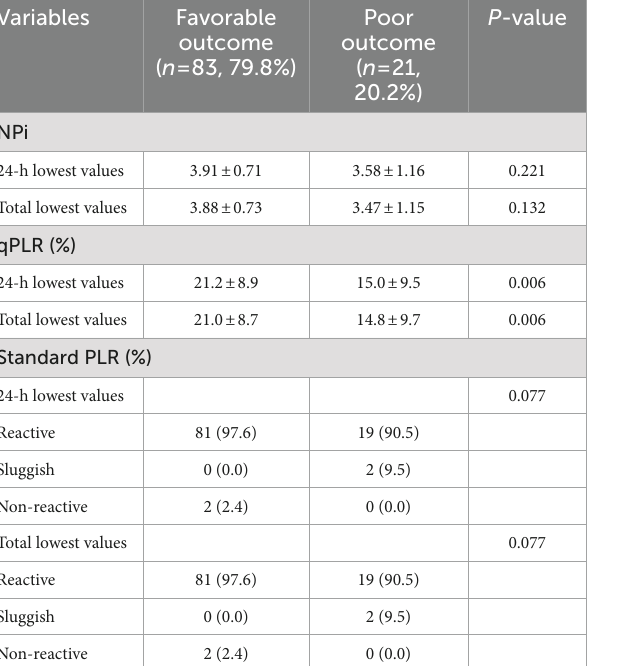
NPi, neurological pupil index; qPLR, quantitative pupillary light reflex. outcomes. In patient 1, sPLR was assessed as non-reactive on admission. However, NPi values were 2.5 (upon admission) and 4.1 (at 24 h); qPLR values were 18% (upon admission) and 26% (at 72 h). In patient 2, sPLR was non-reactive up to 6 h, became sluggish at 12 h, and improved to reactive subsequently. NPi and qPLR values were 1.5 and 15% (upon admission) and improved to more than 2.1 and 20% (at 48 h), respectively. When analyzed at each point in time, qPLR values measured at 12 and 24 h were higher in patients with favorable outcomes than in those with poor outcomes (mean, 32.2 ± 9.7 vs. Table 3). Other pupillometer variables, including maximum pupil size, minimum pupil size, and latency, were compared between the two